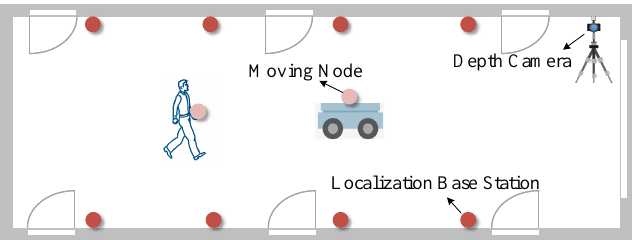
Figure 11. Indoor corridor scene.